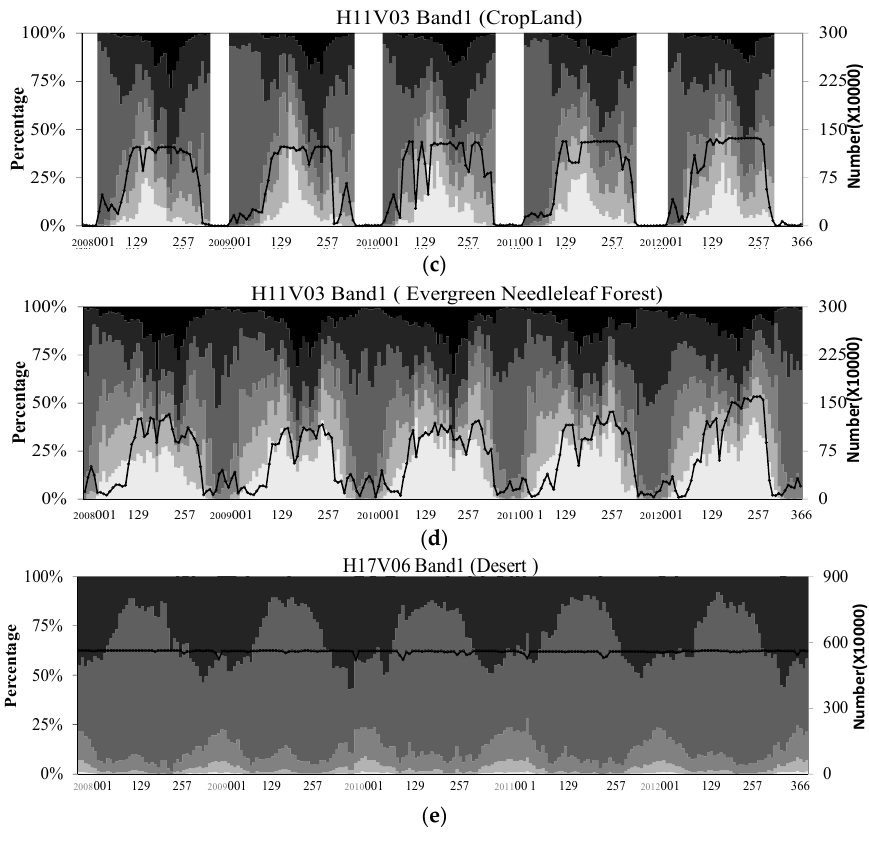
Figure 5. Cumulative histograms regarding the percentage of each BRDF archetype class within grassland ( a ); shrubland ( b ); cropland ( c ); forest ( d ); and desert ( e ) in the red band in three tiles from 2008 to 2012. Different grey levels refer to different BRDF archetype classes. The numbers of pixels used in the calculation are shown together ( black lines ). The white areas in the chart are due to the lack of data.